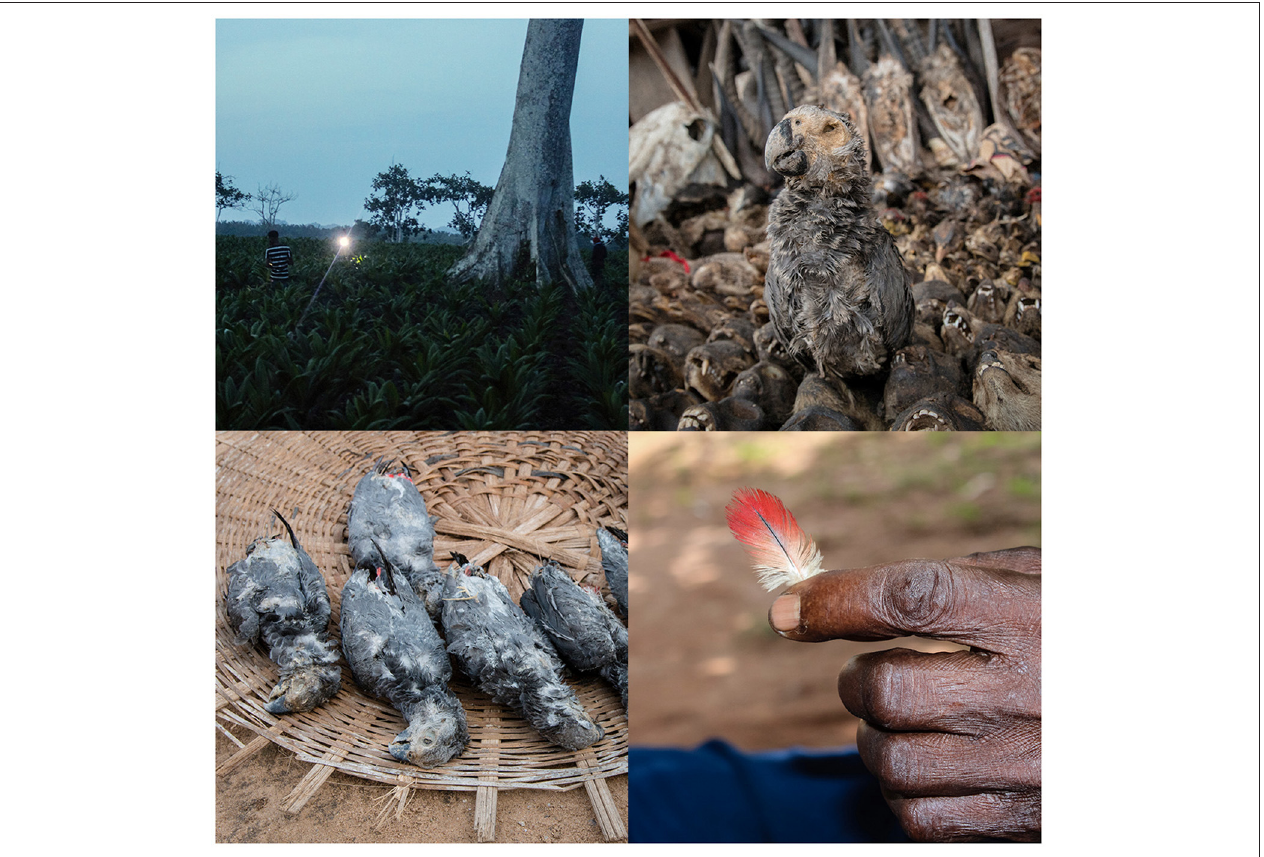
FIGURE 3 | Top left–image of people searching for feathers under a parrot roost in Nigeria (Rowan Martin/World Parrot Trust); top right and bottom left–images of Grey parrot ( Psittacus erithacus ) intended for commercial sale, Togo, West Africa (Neil D’Cruze/World Animal Protection); bottom right Grey parrot tail feather in Nigeria (Rowan Martin/World Parrot